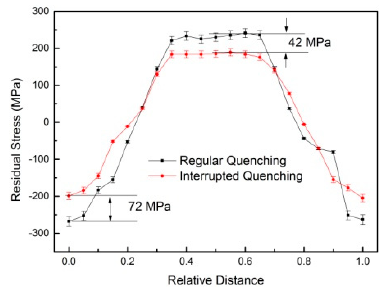
Figure 6. Comparisons of the measured residual stress in different quenching processes using the CCM.